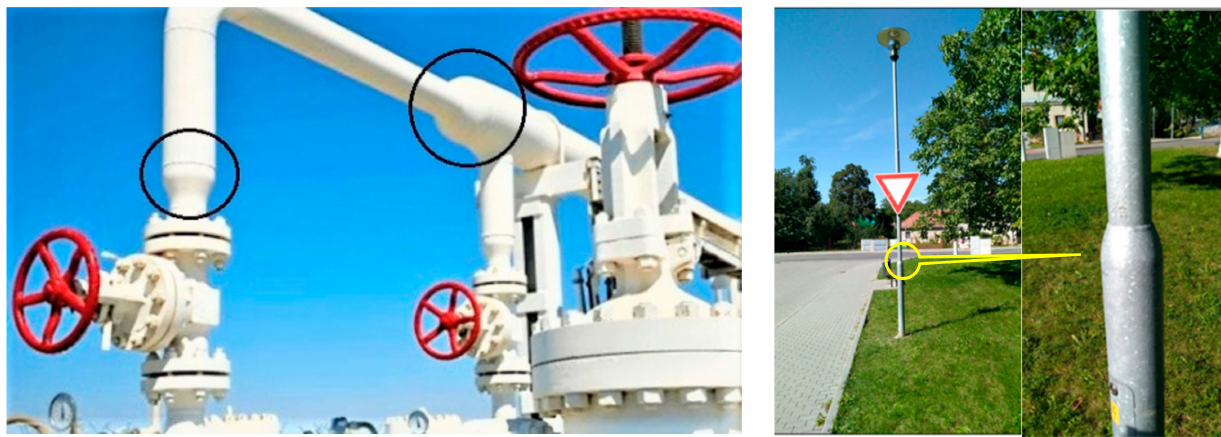
Figure 1. Example of frame structures in the form of ( left ) pipe structure for oil and gas application, as well as ( right ) road and street light